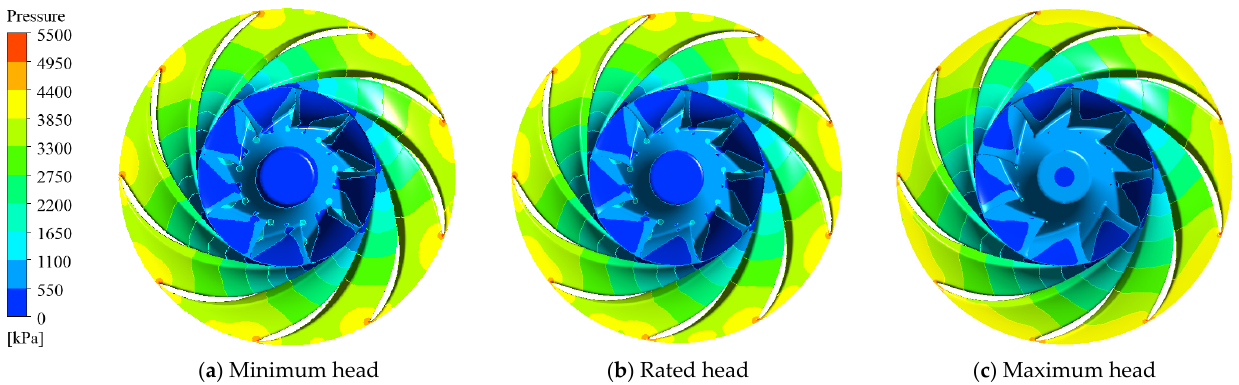
Figure 6. The pressure distribution on the runner's inner surface in three operating heads.